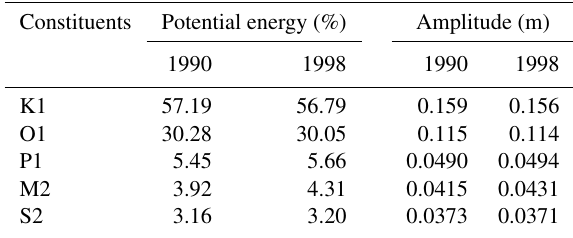
Table 4. Comparison of principal tidal constituents in years 1990 and